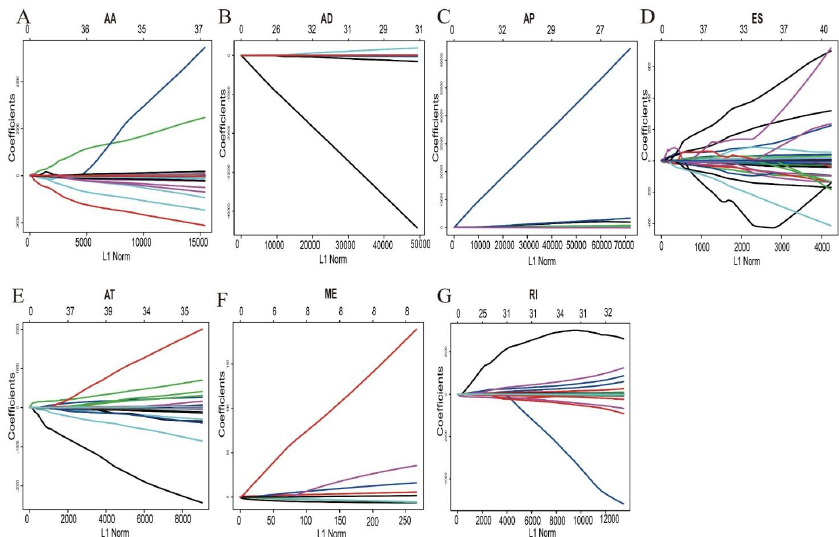
Figure 4. Construction of seven splicing types of prognostic markers based on least absolute shrinkage and selection operator (LASSO) analysis. LASSO coefficient profiles of survival-related alternative splicing (AS) events: ( A ) AA, alternate acceptors; ( B ) AD, alternate donors; ( C ) AP, alternate promoters; ( D ) ES, exon skip; ( E ) AT, alternate terminators; ( F ) ME, mutually exclusive exons; ( G ) RI, retained introns. The lines stand for each survival-related AS events in seven splicing types respectively and candidate AS events were selected by using 10 fold cross-validation via minimum criteria; X-axis is stand for LASSO coefficient profiles of survival-related alternative splicing (AS) events. Y-axis means tuning parameter (lambda) selection in the Lasso regression.